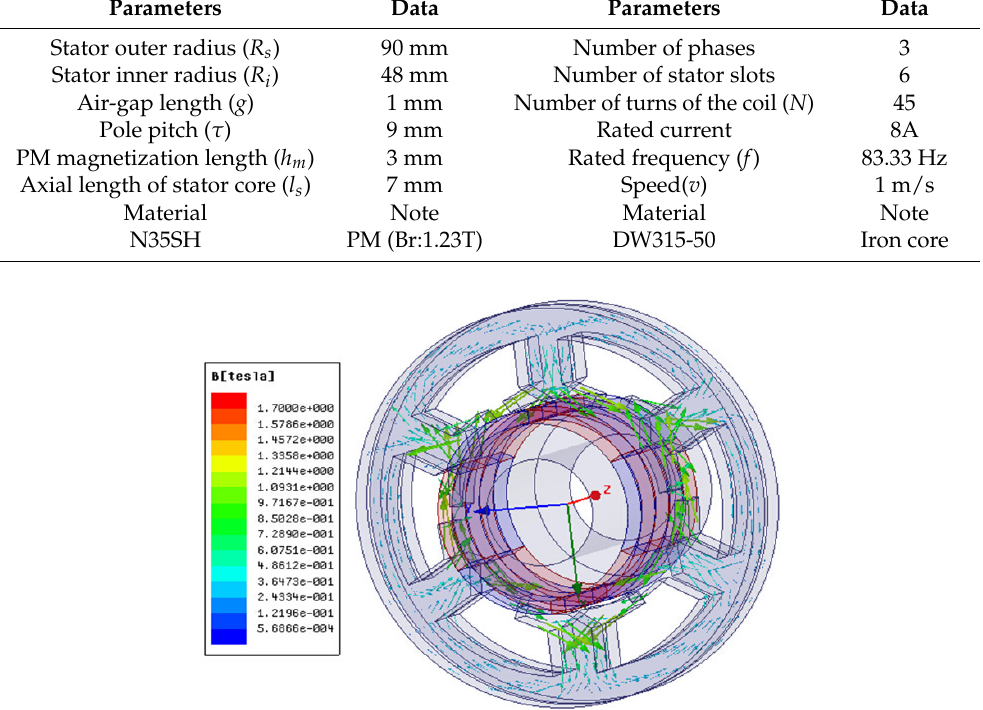
Figure 3. Flux distribution in the stator of STTF ‐ PMLSM under no ‐ load condition.